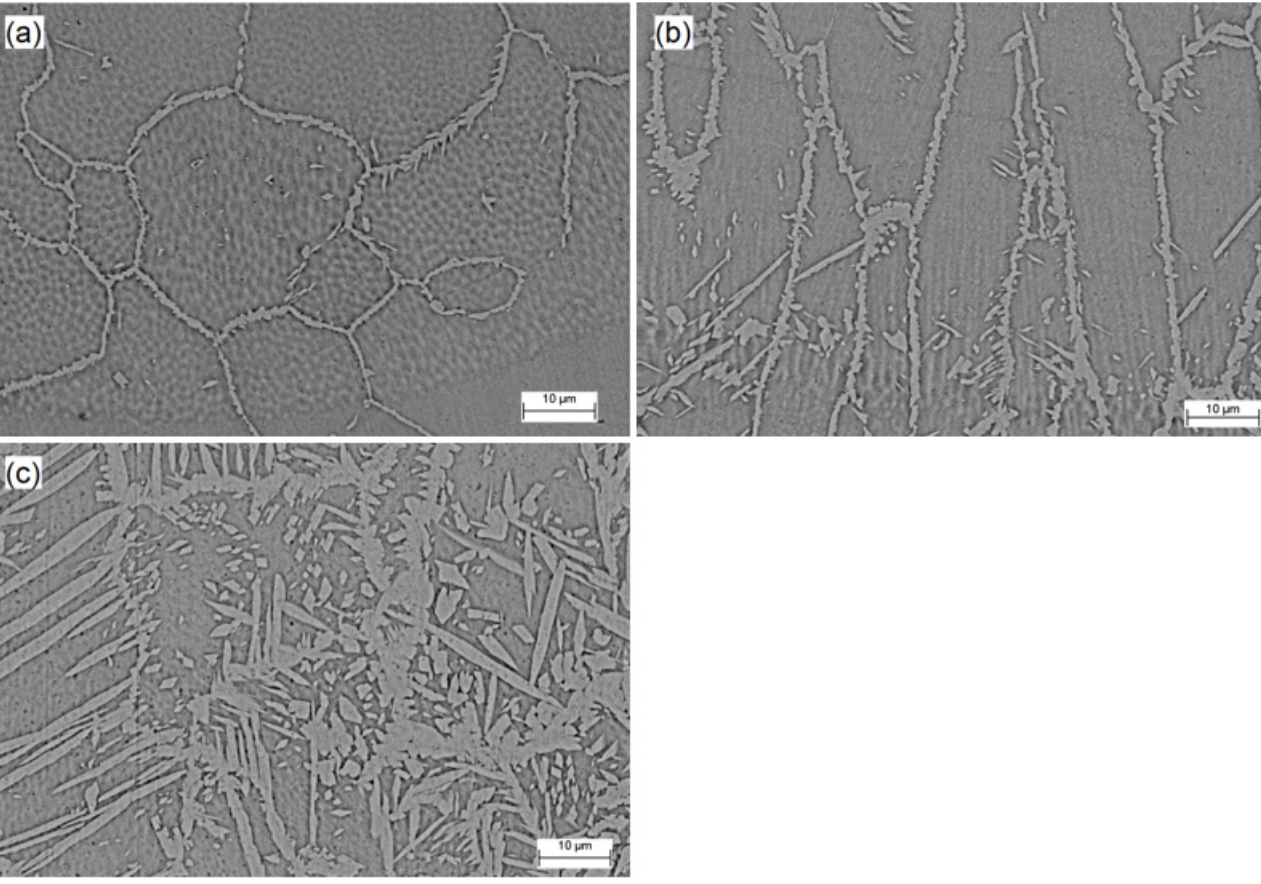
Figure 4. Microstructure of fusion zone (SEM micrographs) for ( a ) Co12, ( b ) Co20 and ( c ) Co35.